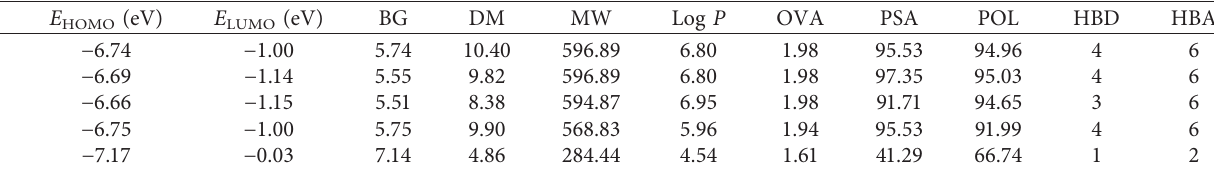
Table 1: Calculated molecular descriptors of the studied